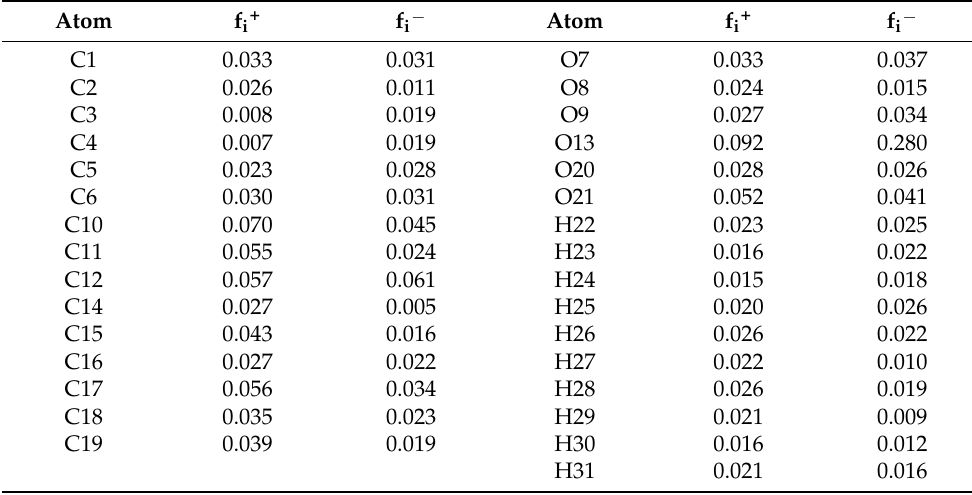
Figure 12. The atomic coding: ( a ) luteolin, ( b ) apigenin and ( c ) α -linolenic acid. Table 3. Fukui function of luteolin.